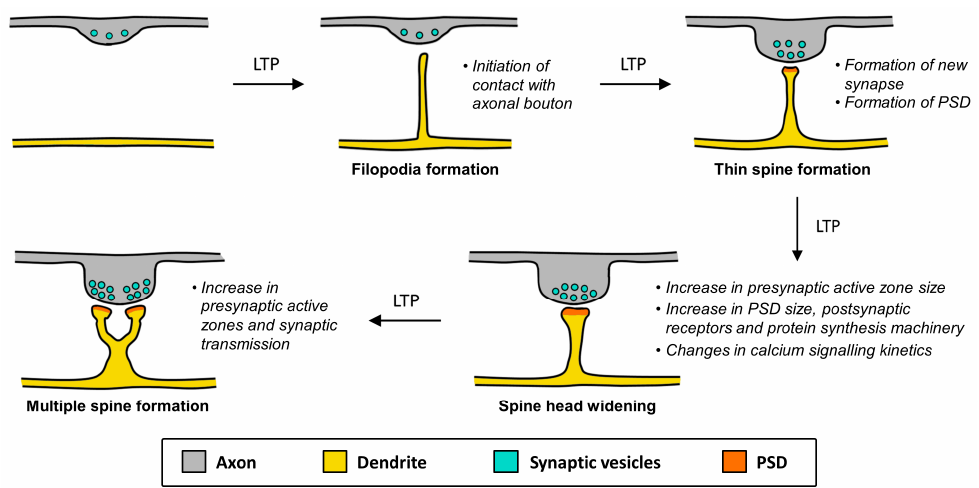
Figure 1. Spine morphogenic effects of long-term potentiation (LTP). Dendritic spines sprout and alter their morphology in an activity-dependent manner. LTP leads to the protrusion of filopodia and immature spines from the dendritic shaft and eventually spine maturation. Multiple spines can also synapse onto the same axonal bouton. These morphological changes are accompanied by alterations in cell physiology that impact synaptic transmission, which include the formation of the postsynaptic density (PSD), changes in the quantity of synaptic vesicles and postsynaptic neurotransmitter receptors, and changes in calcium compartmentalisation.